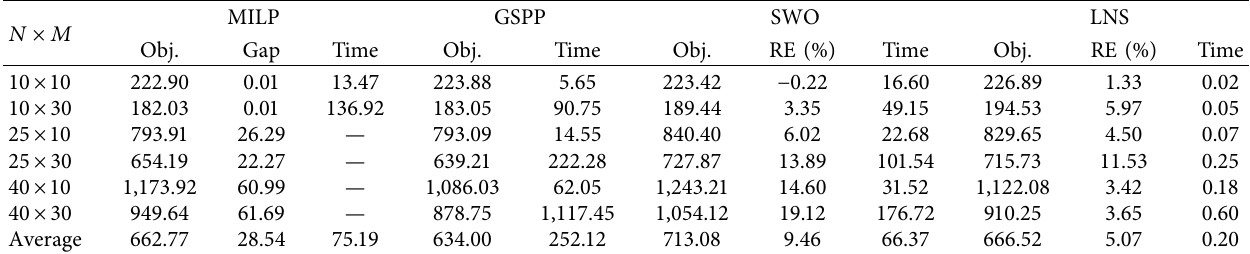
Table 2: LNS performance results for deterministic